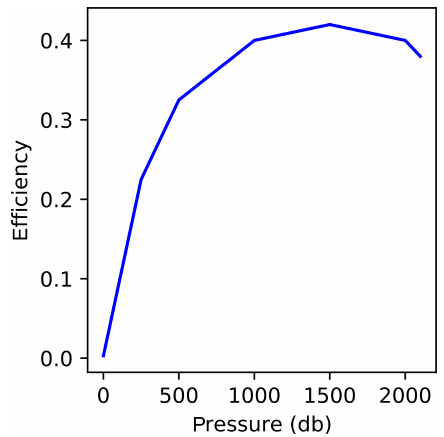
Figure 1. Typical buoyancy engine efficiency (electric to p – V work) variation with profiling pressure.